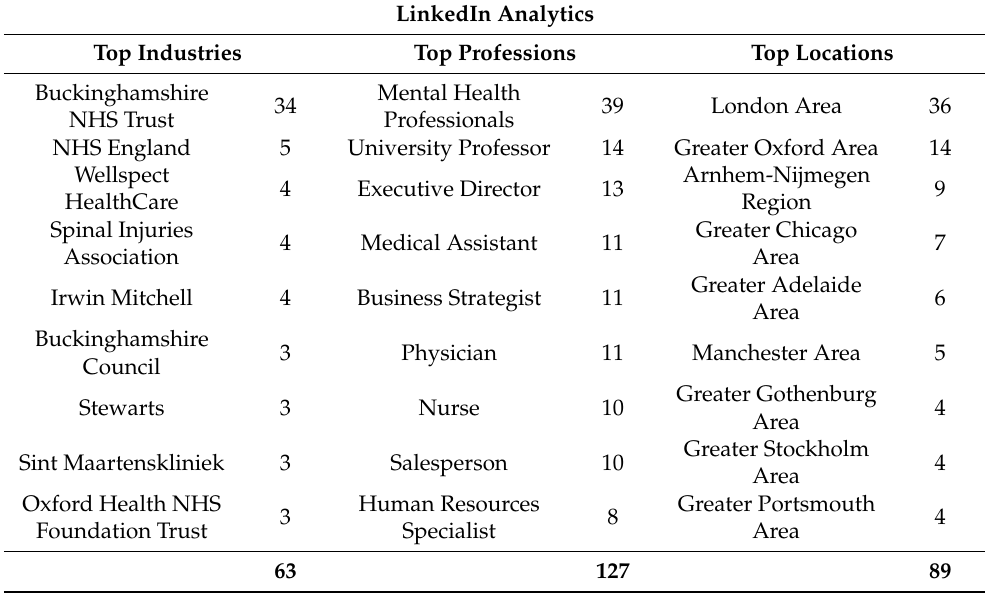
Table 3. LinkedIn analytics from survey posts.